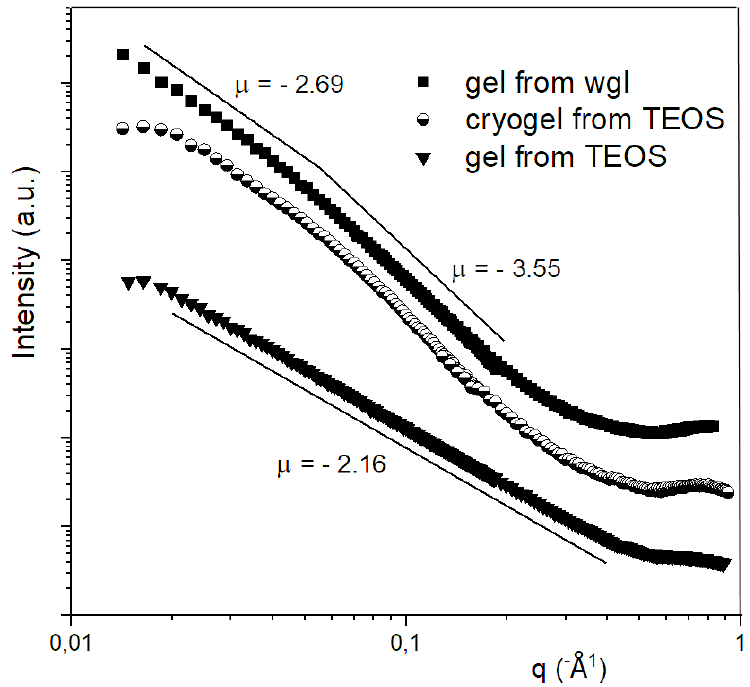
Figure 6. SAXS curves for alcogel from TEOS, hydrogel from water glass, and cryogel from TEOS.